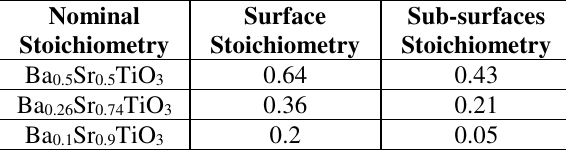
Table 1. Barium concentration depth